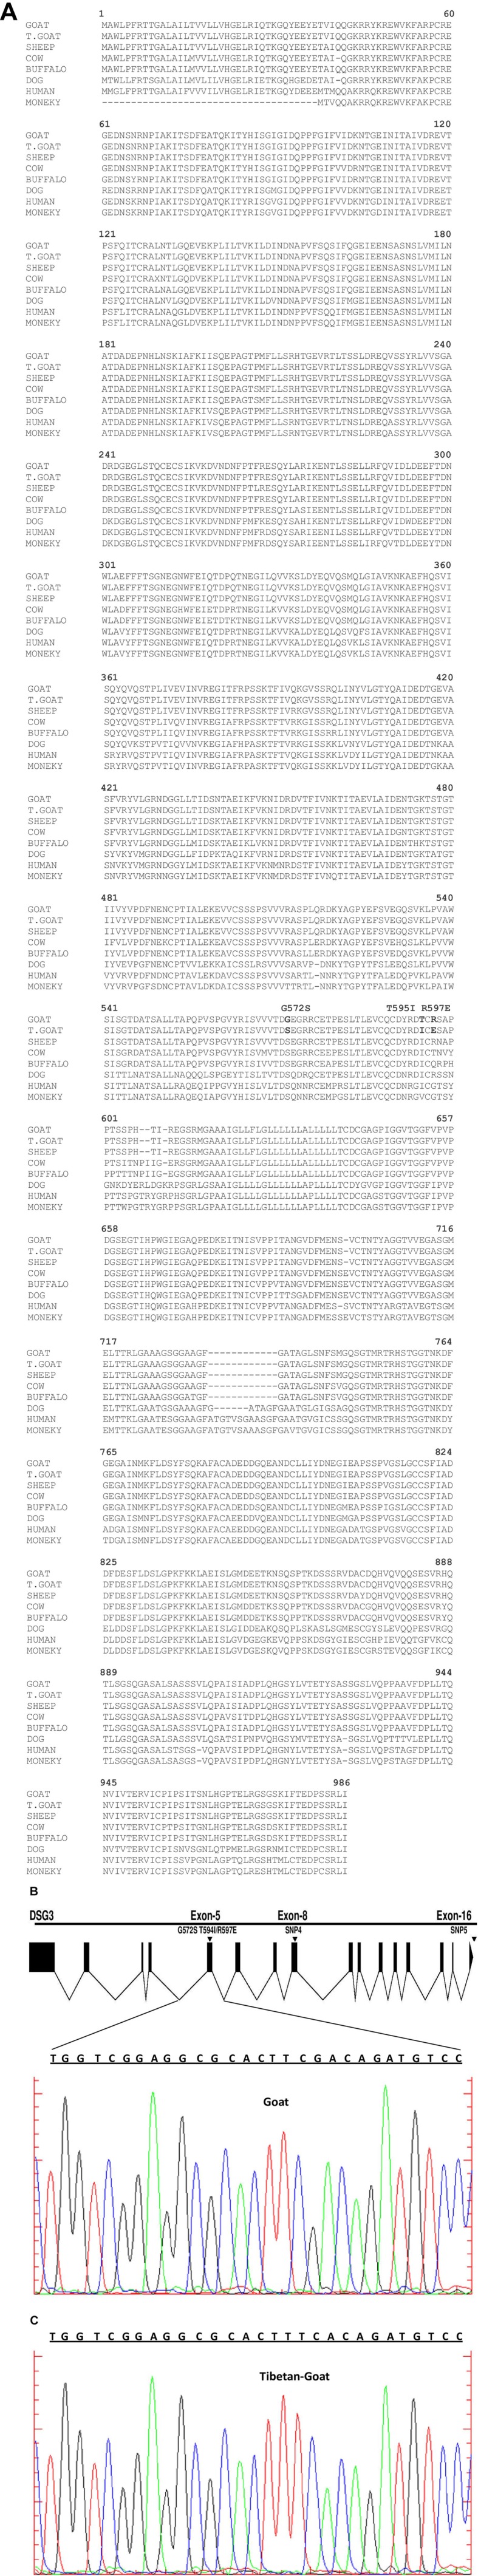
(A) Protein sequence alignment among different mammalian aligned by cluster omega (Sievers et al., 2011) predicated non-synonymous mutation in Tibetan goat, a conserver site or polymorphism. The dashes indicate deletions. (B) Sanger sequence of blue and black region showed nucleotide position changed in lowland goat, blue indicated nucleotide C, while black indicated nucleotide G. (C) Sanger sequence of red and blue region indicated nucleotide position changed in Tibetan goat, red indicated nucleotide T, while Blue indicated nucleotide C.